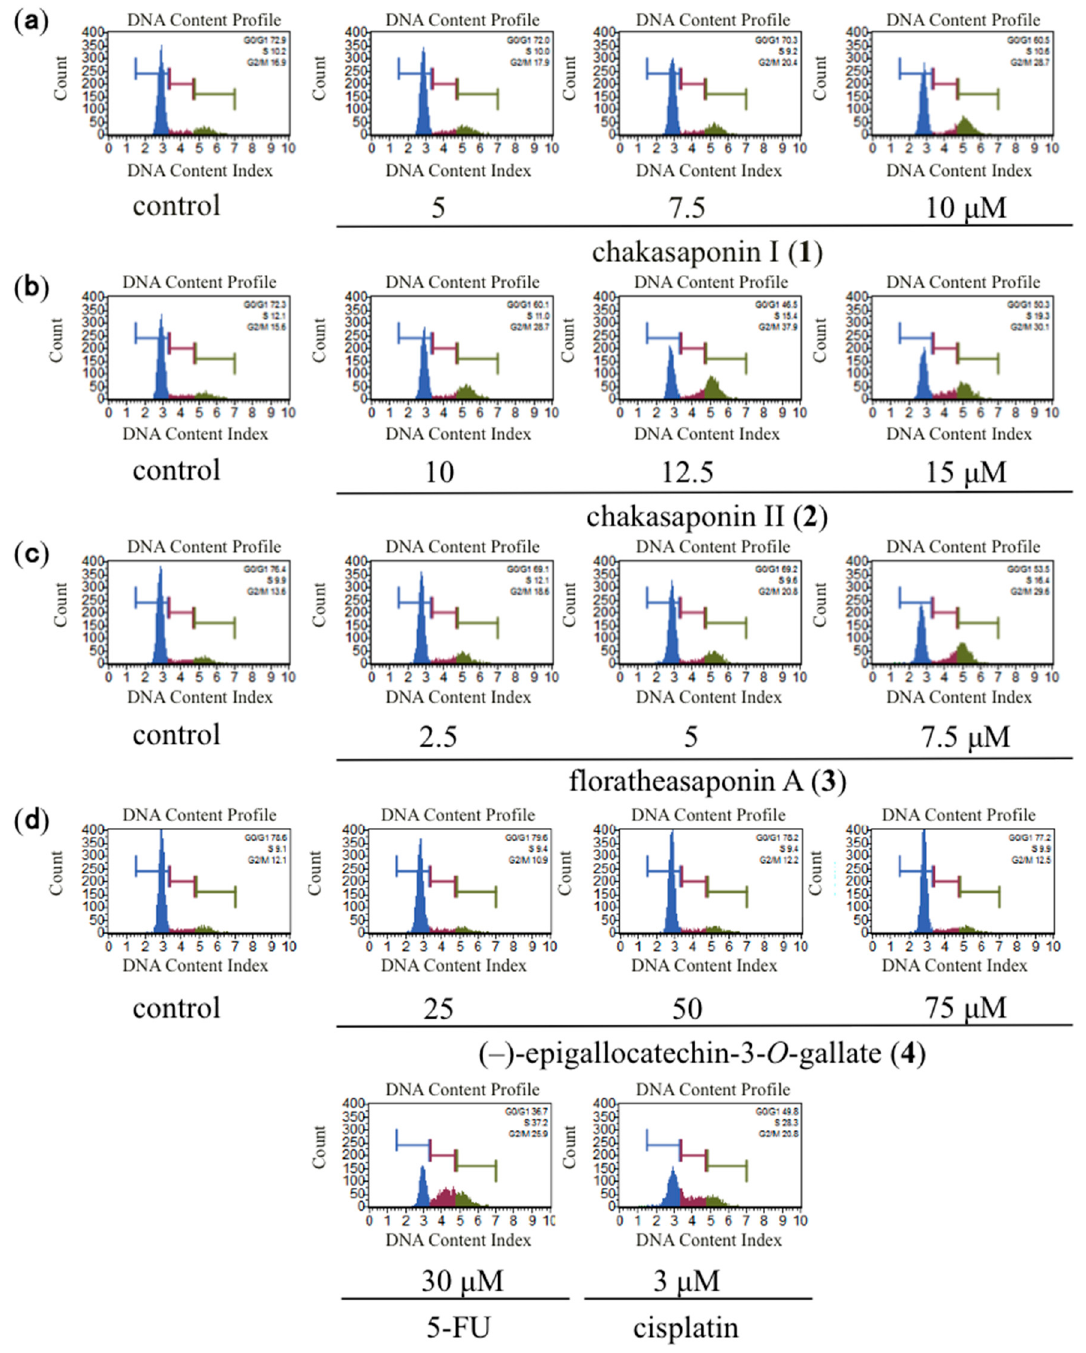
Figure 2. Effects of 1 – 4 , 5-FU, and cisplatin on the cell cycle distribution of HSC-2 cells. Cell cycle distribution was measured by Muse ® Cell Analyzer using a Muse Cell Cycle Kit (Merck Millipore, Darmstadt, Germany); HSC-2 cells were treated with ( a ) 5, 7.5, and 10 µM of 1 ; ( b ) 10, 12.5, and 15 µM of 2 ; ( c ) 2.5, 5, and 7.5 µM of 3 ; ( d ) 25, 50, and 75 µM of 4 , 30 µM of 5-FU, and 3 µM of cisplatin for 48 h; the data represent the mean percentages ± SD of total apoptosis ( n = 3); commercial 5-FU and cisplatin were purchased from Wako Pure Chemical Industries, Ltd. (Osaka, Japan).